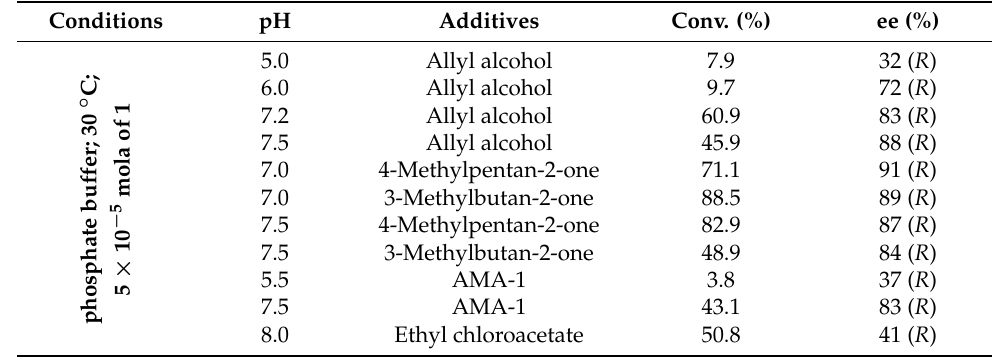
Table 10. Bioreduction of 1 Catalyzed by A. pullulans Strain DSM 14940 and DSM 14941 in Specific Conditions with Selected Additives.